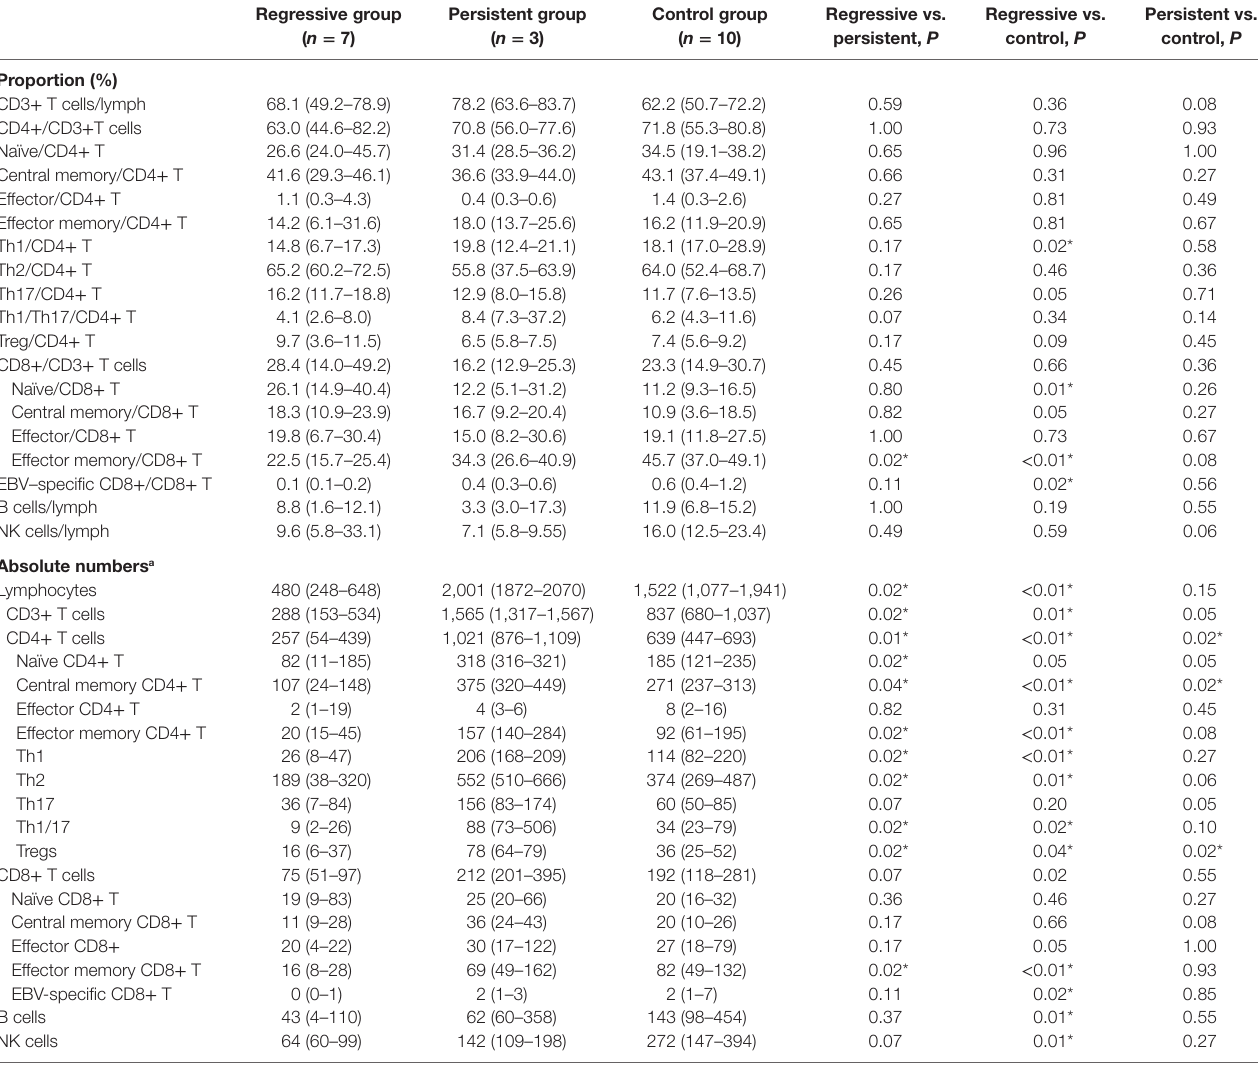
TaBle 3 | Proportion and absolute numbers of lymphocyte